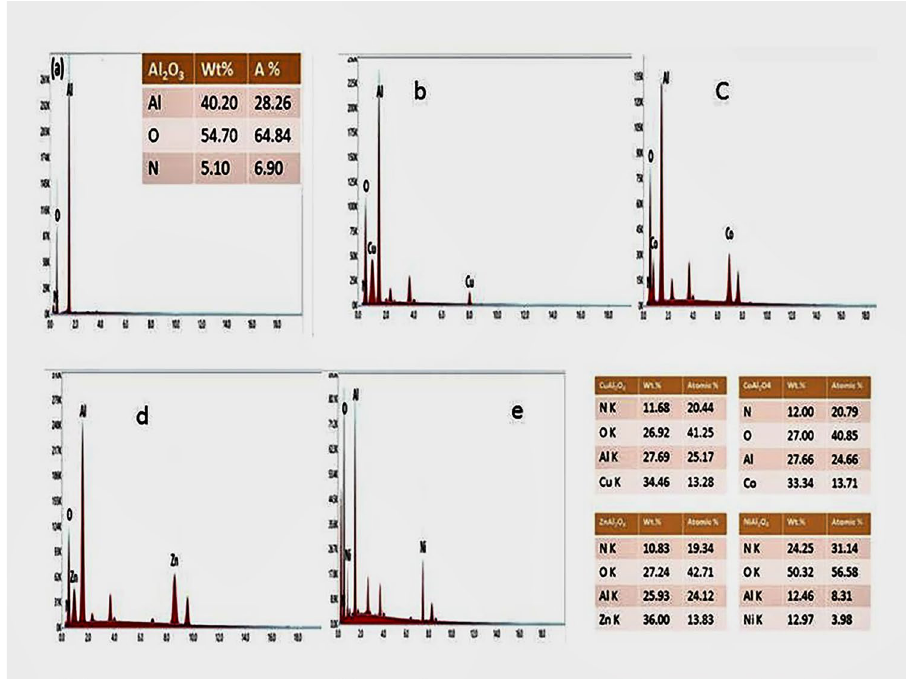
Figure 4. EDX analysis of ( a )-Al 2 O 3 NP s , ( b )-CuAl 2 O 4 , ( c )-CoAl 2 O 4 , ( d )-ZnAl 2 O 4 and ( e )-NiAl 2 O 4